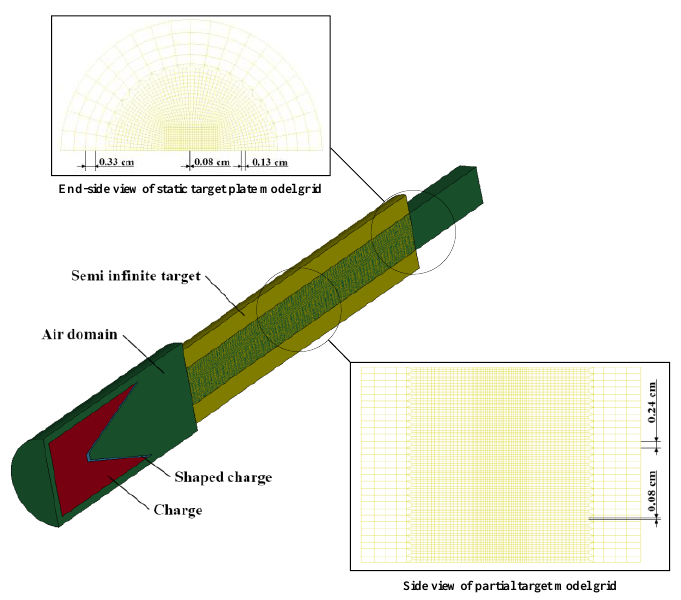
Figure 2. Schematic diagram of jet static penetration.